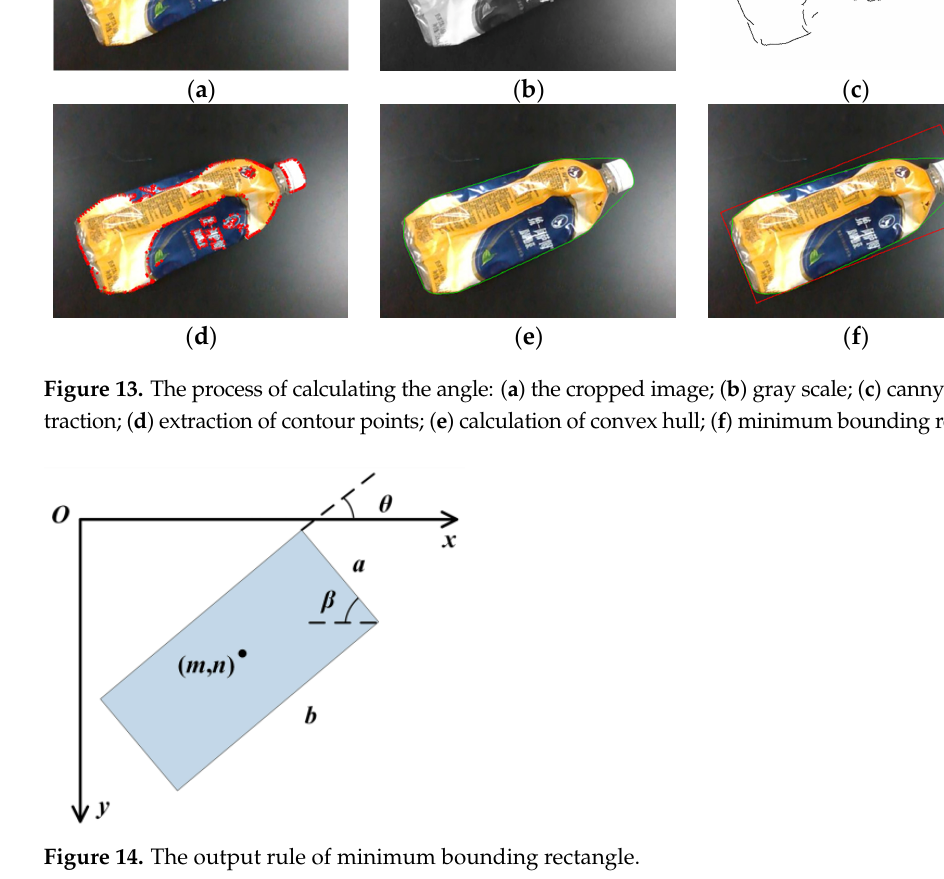
Figure 14. The output rule of minimum bounding rectangle.